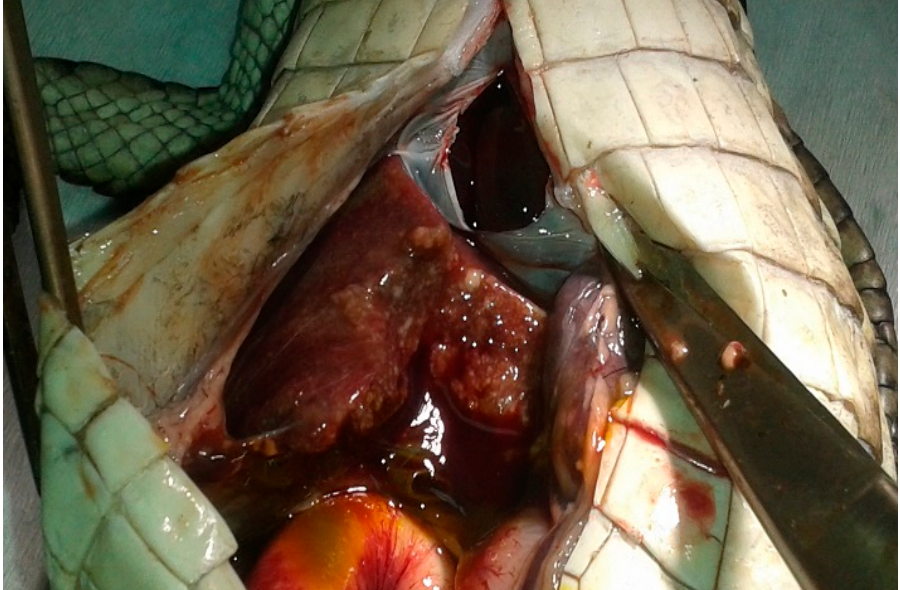
Figure 2. Enlarged liver with white to yellowish nodules.